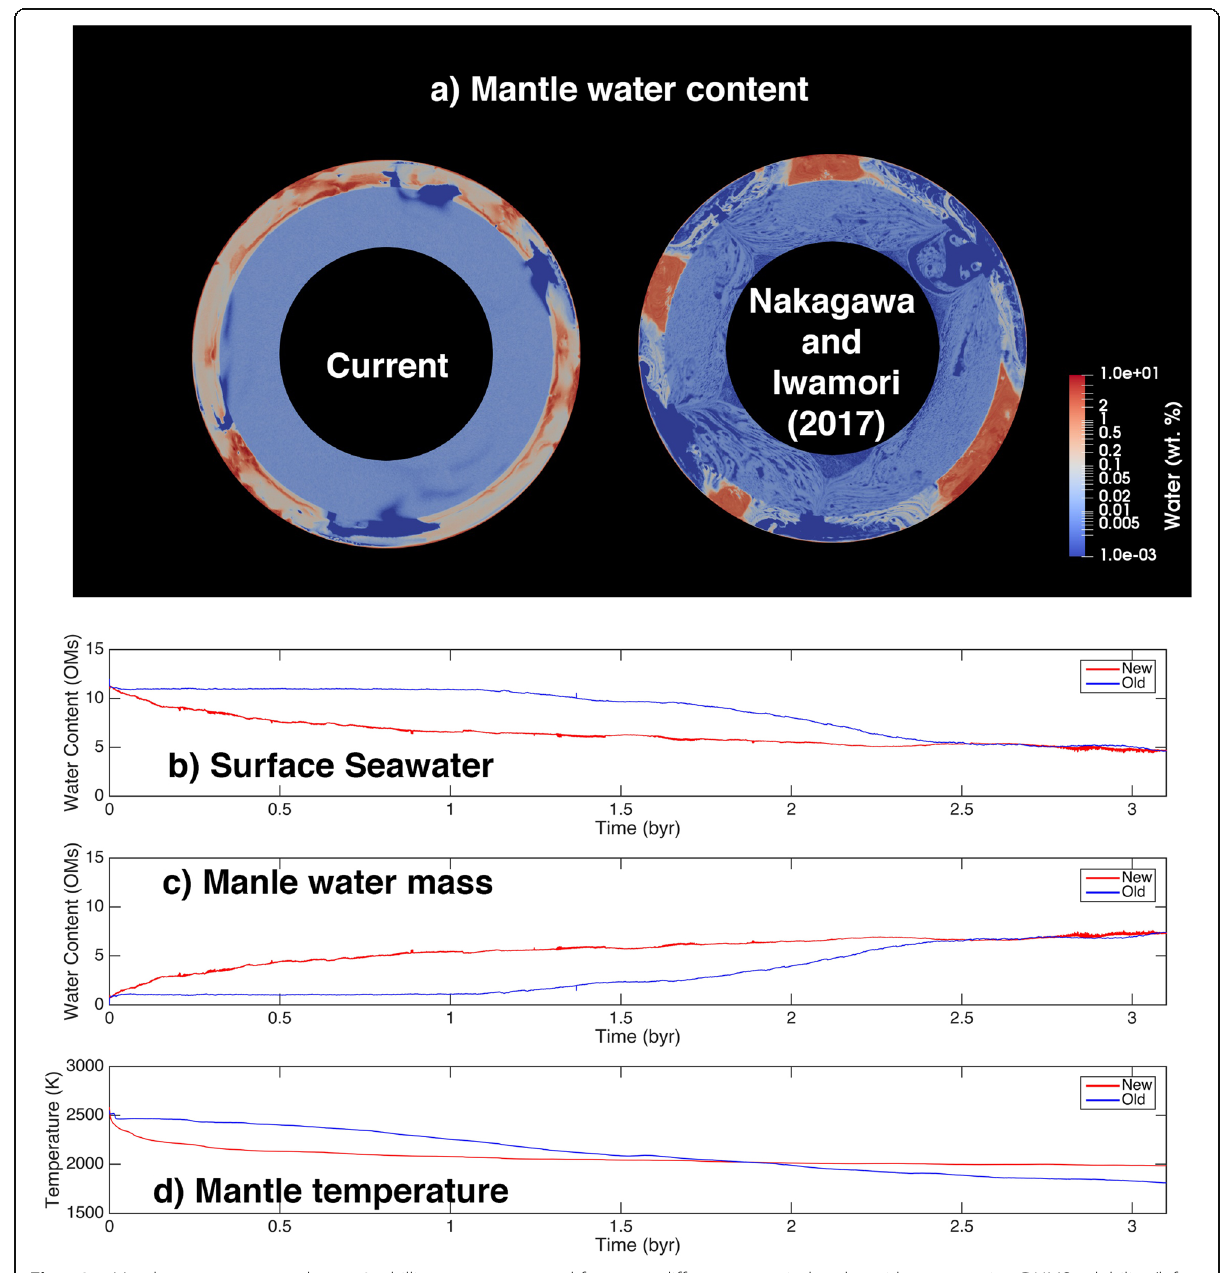
Fig. 10 a Mantle water content taken at 3.1 billion years computed from two different numerical codes without assuming DHMS solubility (left: current version of numerical code; right: the version used in Nakagawa and Iwamori (2017) but corrected for significant issues with the dehydration reaction) and their diagnostics ( b evolution of surface seawater, c mantle water mass, and d mantle temperature) as a function of time. On the legend of diagnostics plots, new represents a result from the numerical code used in this study and old represents a result from the numerical code used in Nakagawa and Iwamori